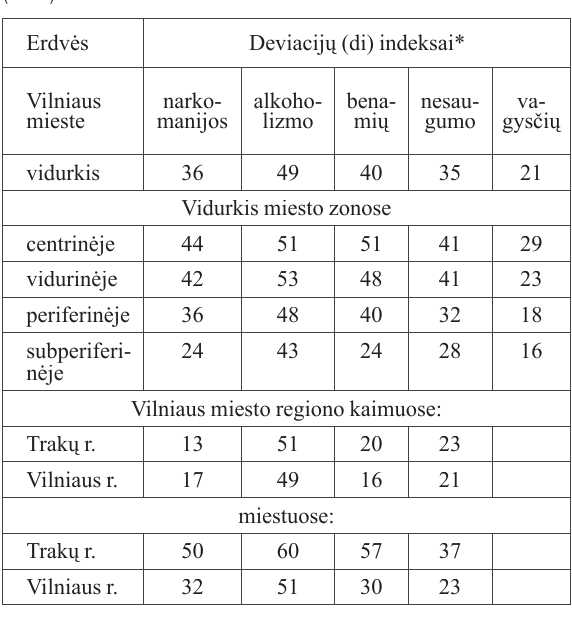
(2005 m.) Table 2. Spread of the social deviation in the Vilnius city and region